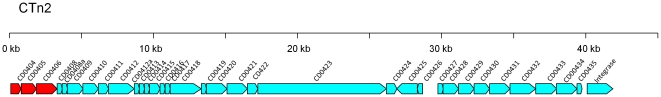
Schematic representation of CTn2 in strain 630.ORFs in blue are now predicted to be part of CTn2, ORFs shown in red were previously thought to be part of the element [8] but were present in the target site after excision (see text for more details).